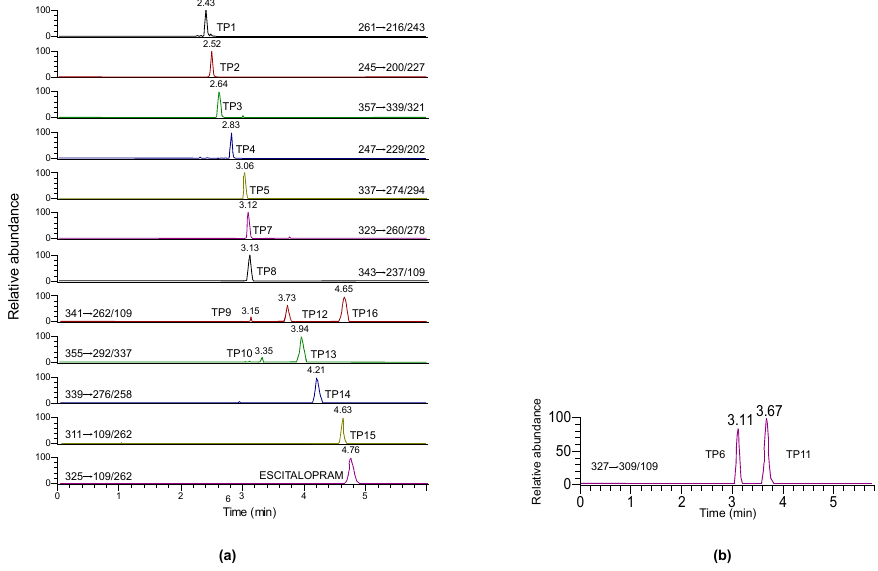
Figure 2. ( a ) Chromatographic peaks of ESC and TPs in ultrapure water after irradiation for 179 h; ( b ) additional chromatographic peaks of TPs formed in lake water for the same time of irradiation. TPs were found; among them, one (TP1) was detected for the first time.